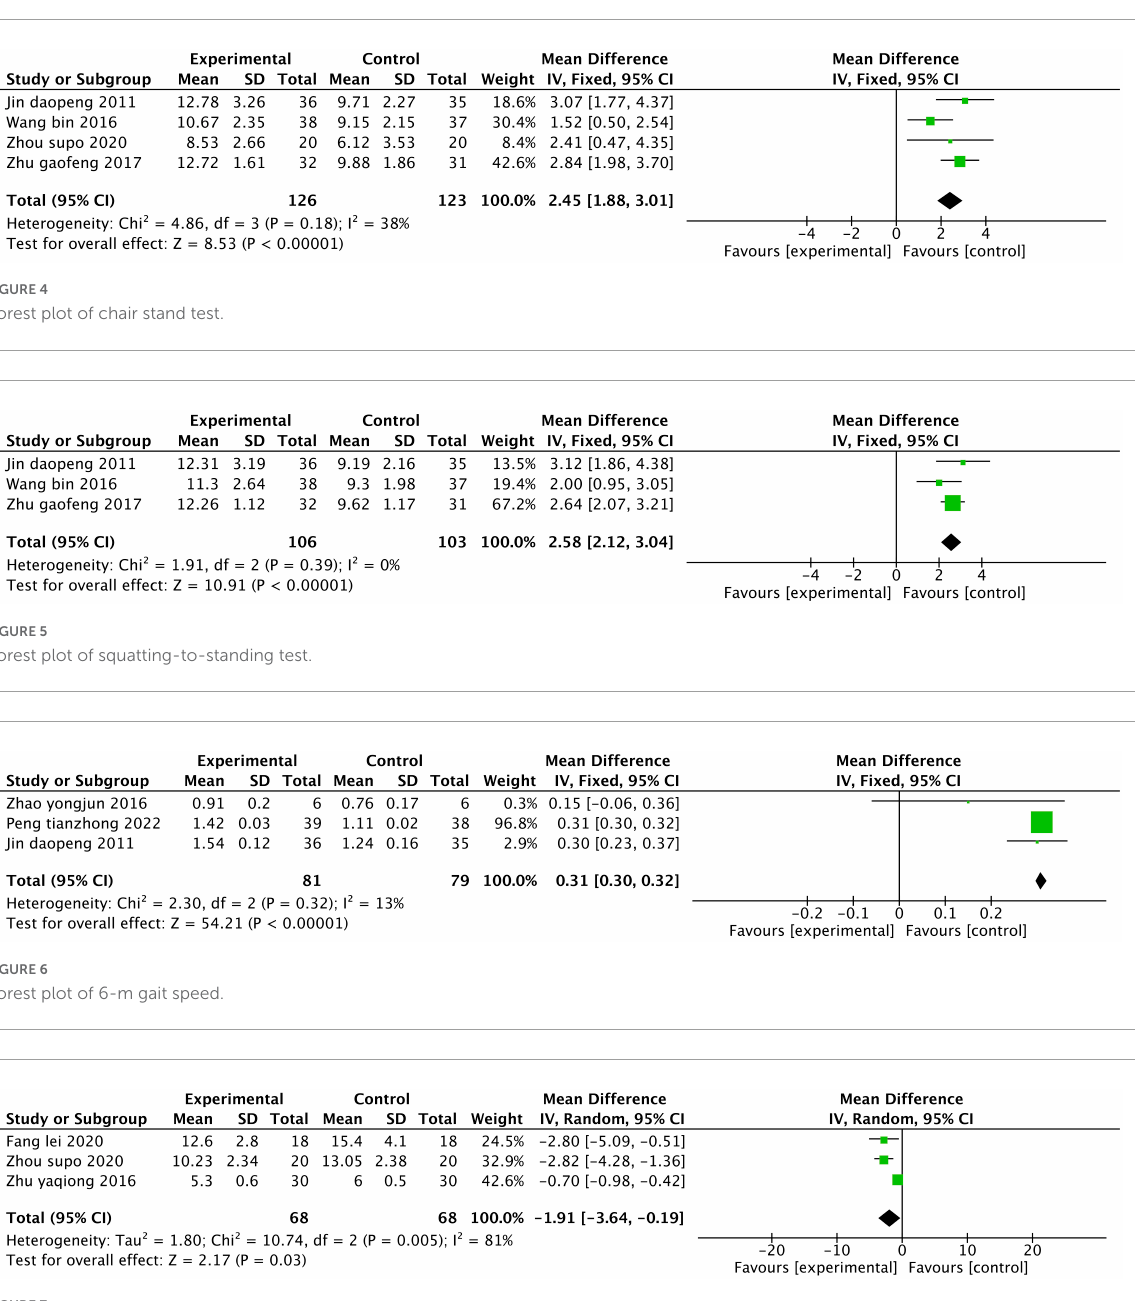
FIGURE7 Forest plot of time up and go